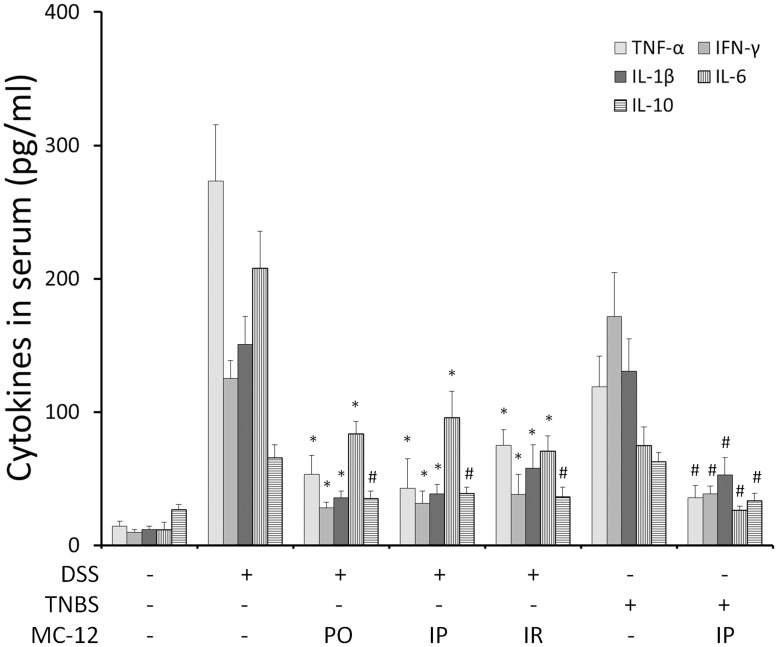
MC-12 reduces the serum levels of cytokines.The serum levels of TNF-α, IFN-γ, IL-1β, IL-6 and IL-10 were measured by ELISA as in Methods. Both DSS and TNBS induced their levels and treatments with MC-12, 25 mg/kg administered PO, IP or IR reduced these levels 1.6- to 5.1-fold. *p<0.01, #p<0.05 compared to vehicle-treated controls.